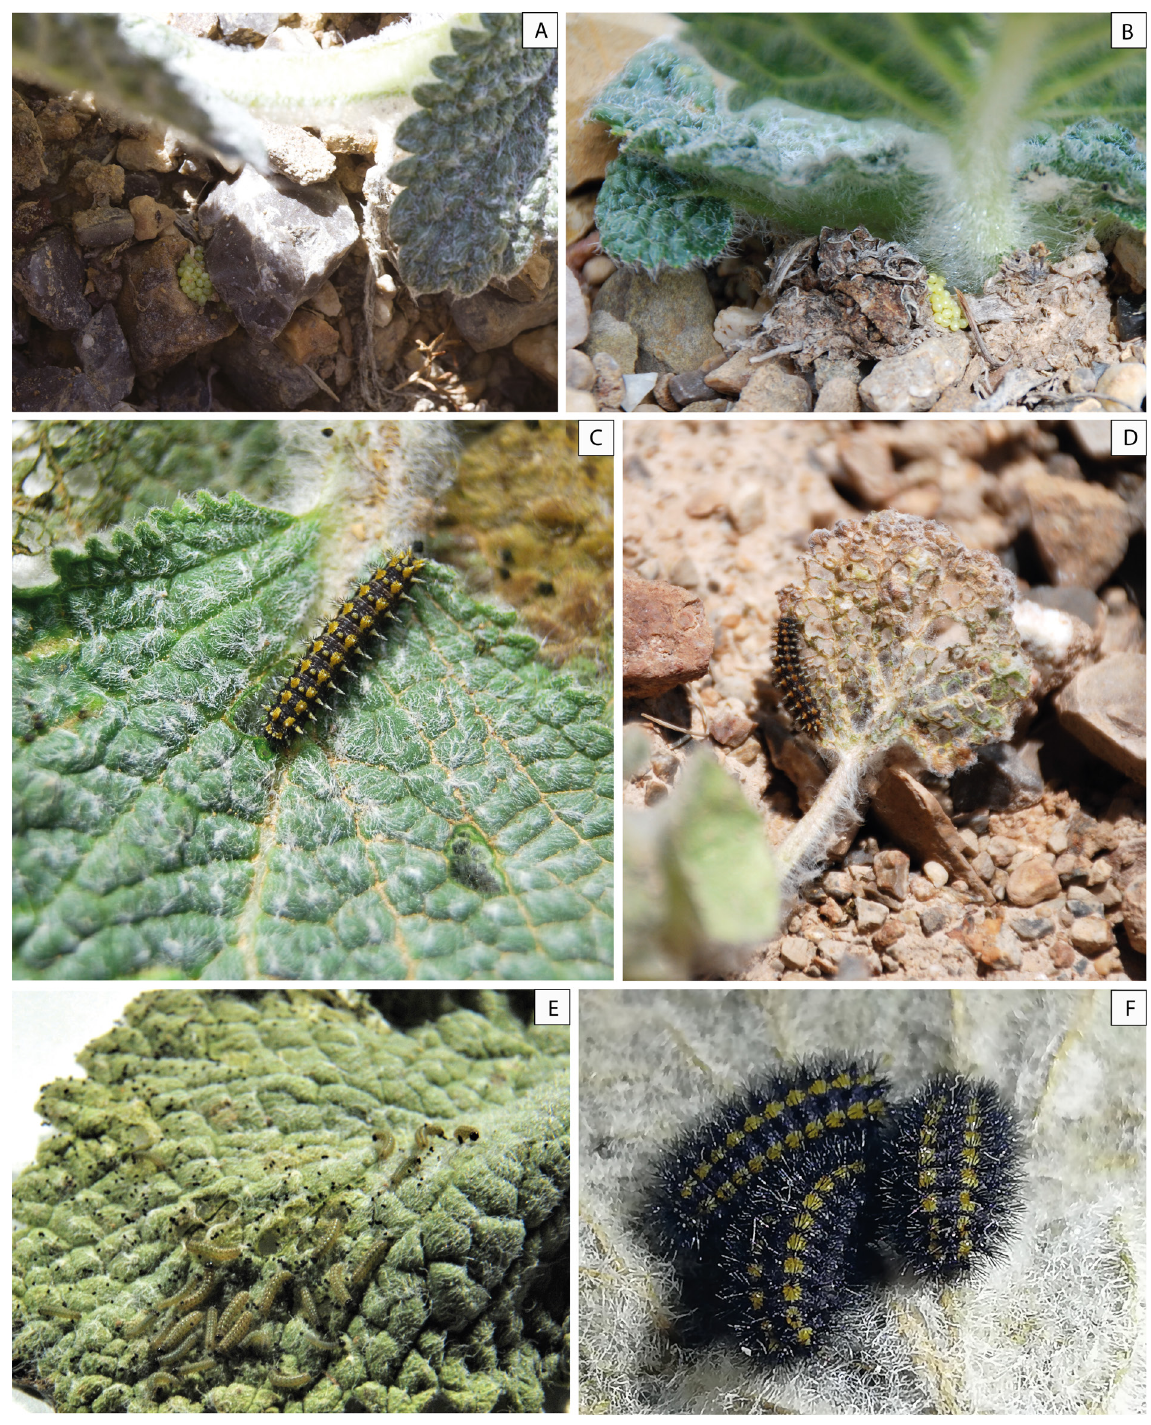
Fig. 28. Eggs and caterpillars of Melitaea shahvarica sp. nov. in nature and in the laboratory. A–B . Freshly laid eggs under a leaf of a host plant, May 2018, Iran, Shahvar Mt., alt. 2200 m. C–D . IV–V instar caterpillars on the leaves of the host plant Phlomoides molucelloides (Bunge) Salmaki, July 2019, Iran, Shahvar Mt., alt. 2500 m. E . I instar caterpillars in the laboratory, Moscow, May 2018. F . VI